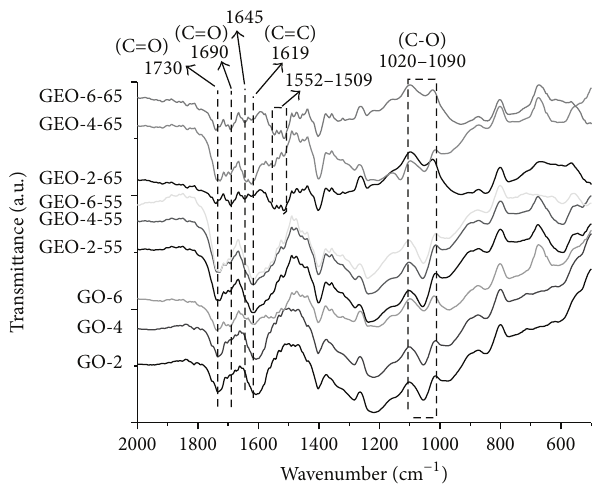
Figure 1: FT-IR spectra of GO-2, GO-4, GO-6, GEO-2-55, GEO-4- 55, GEO-6-55, GEO-2-65, GEO-4-65, and